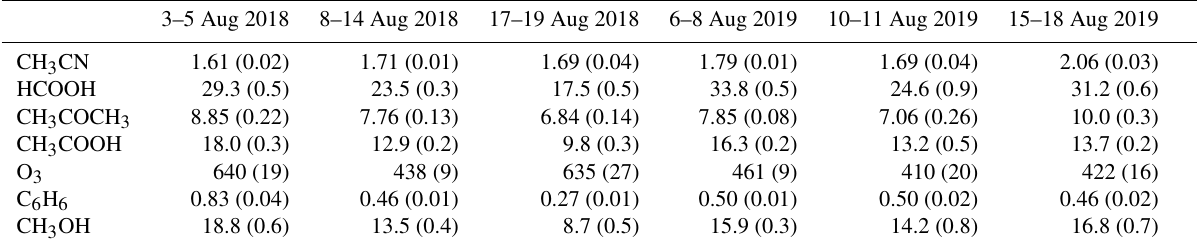
Table 5. Calculated EnRs (pptv ppbv − 1 ) – relative to CO – for the identified BB intrusions. Between parentheses are the standard deviations of the EnR (pptv ppbv − 1 ) obtained from the linear